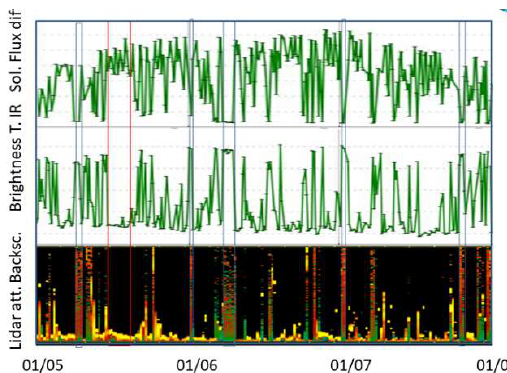
Fig. 3 : Time series of lidar background radiance (top), temperature brightness (middle) and lidar signal between 0 and 5 km (low) measured by platform B24 from the beginning of May to the end of July 2017, showing cloud and aerosol occurrence observed with the lidar and impact on radiation (see text).